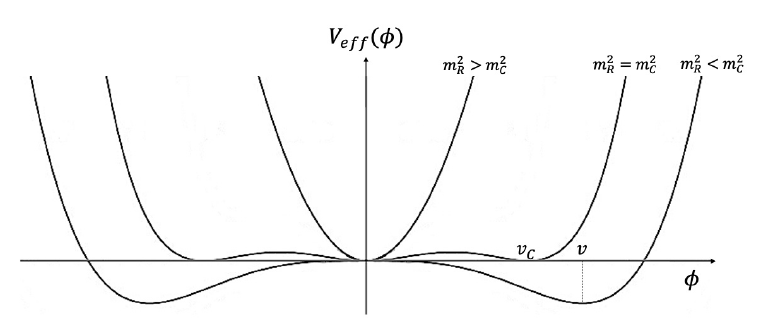
Figure 1. A schematic profile of the effective potential where SSB is a 1st-order phase